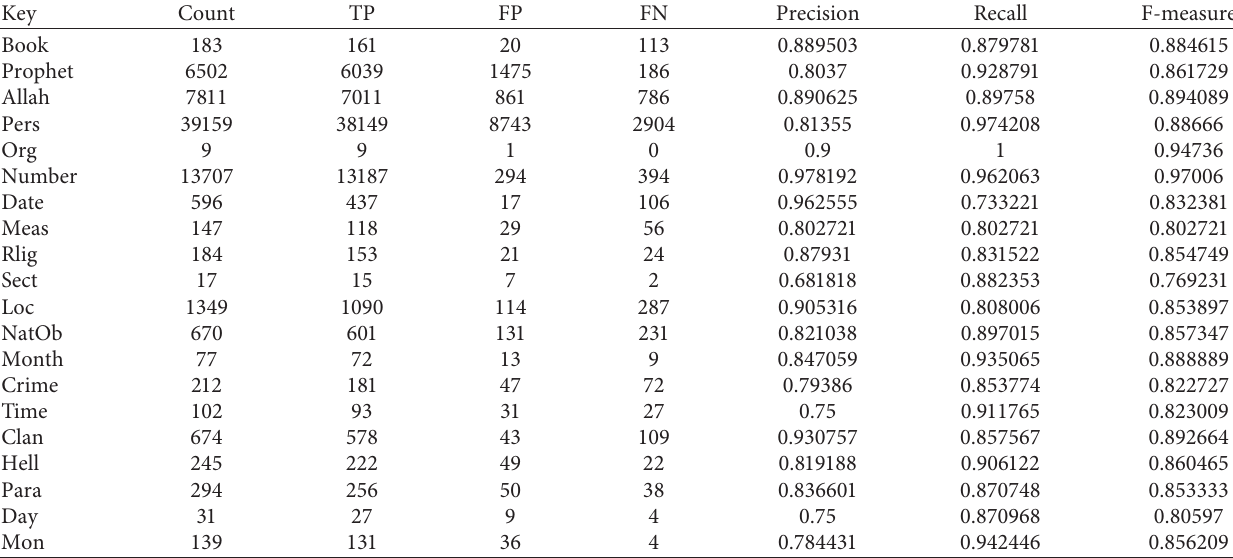
Table 15: Results of not using blacklist.